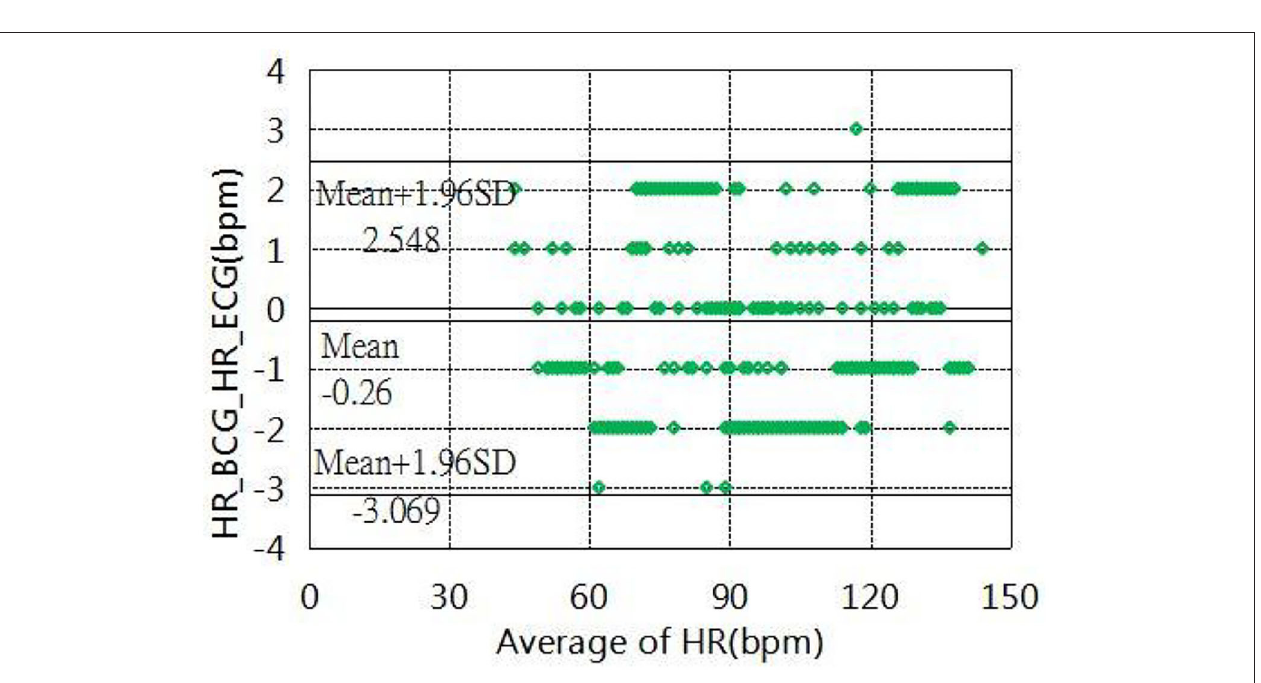
Hospital and Temple of Heaven Hospital, Beijing, China). More specifically, the tests of heart rates were recorded with 215 groups of data measured for different individuals, which were analyzed